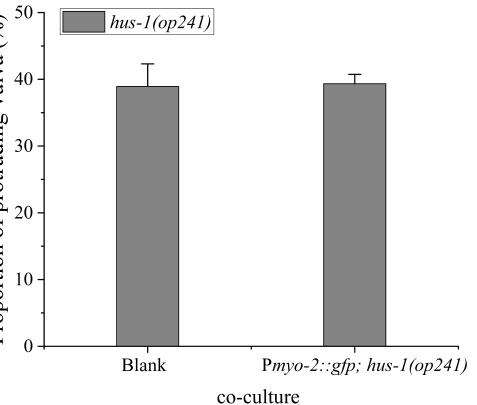
Figure A2. The vulval radiosensitivity of hus-1 worms co-cultured with BPL1101 worms. Blank: culture alone. Results are means ± SD ( n ≥ 3, t